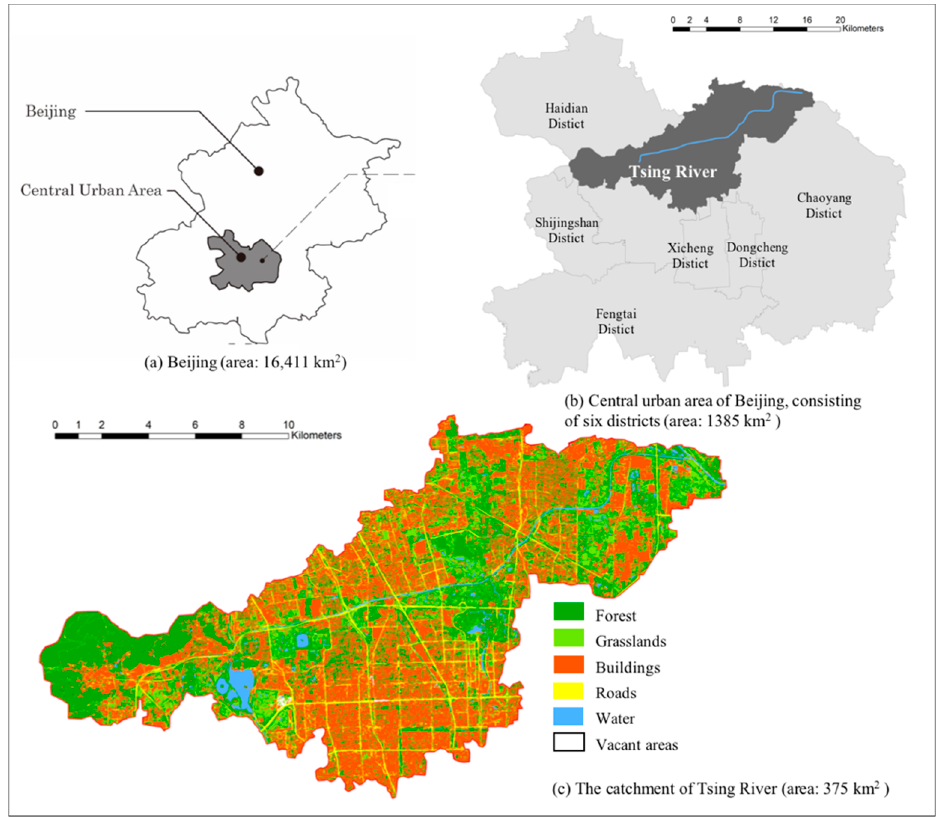
Figure 1. The location and the catchment of the Tsing River. Land covers were interpreted from Gaofen-2 remote sensing image.